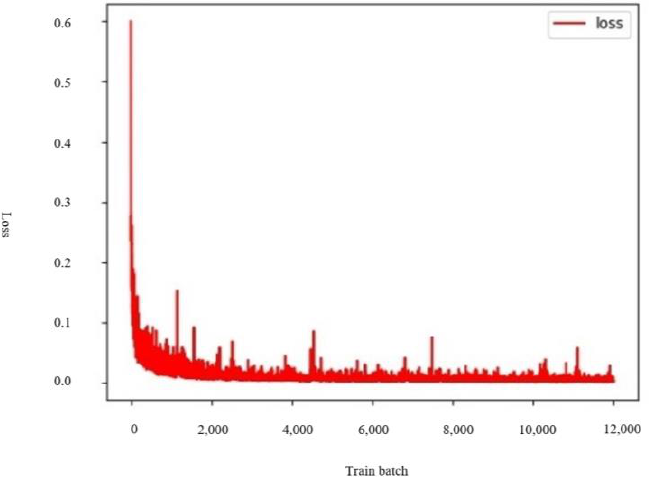
Figure 4. The cross-entropy loss of the attention-based DCNN on generated data sets.